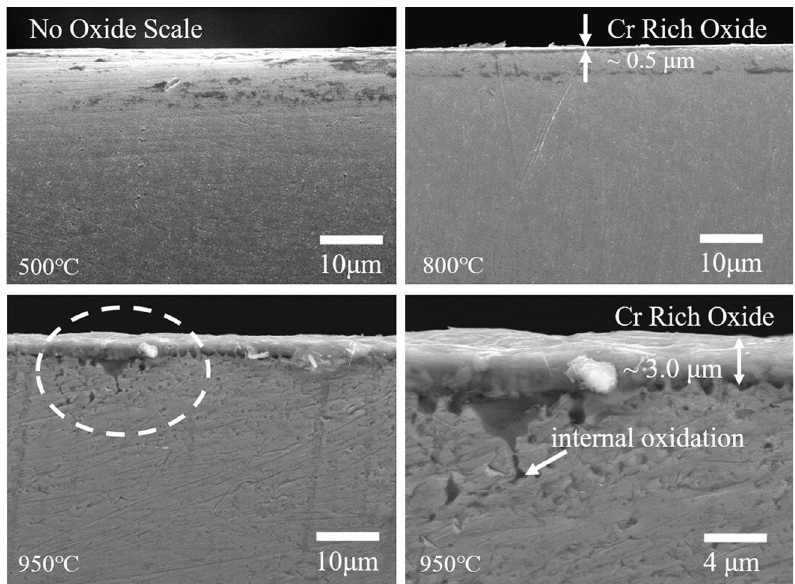
Figure 4: FESEM picture at 20keV with an SEI (secondary electron imaging) contrast; Incoloy 800H under impure helium at 500 ° C, 800 ° C, and 950 ° C.